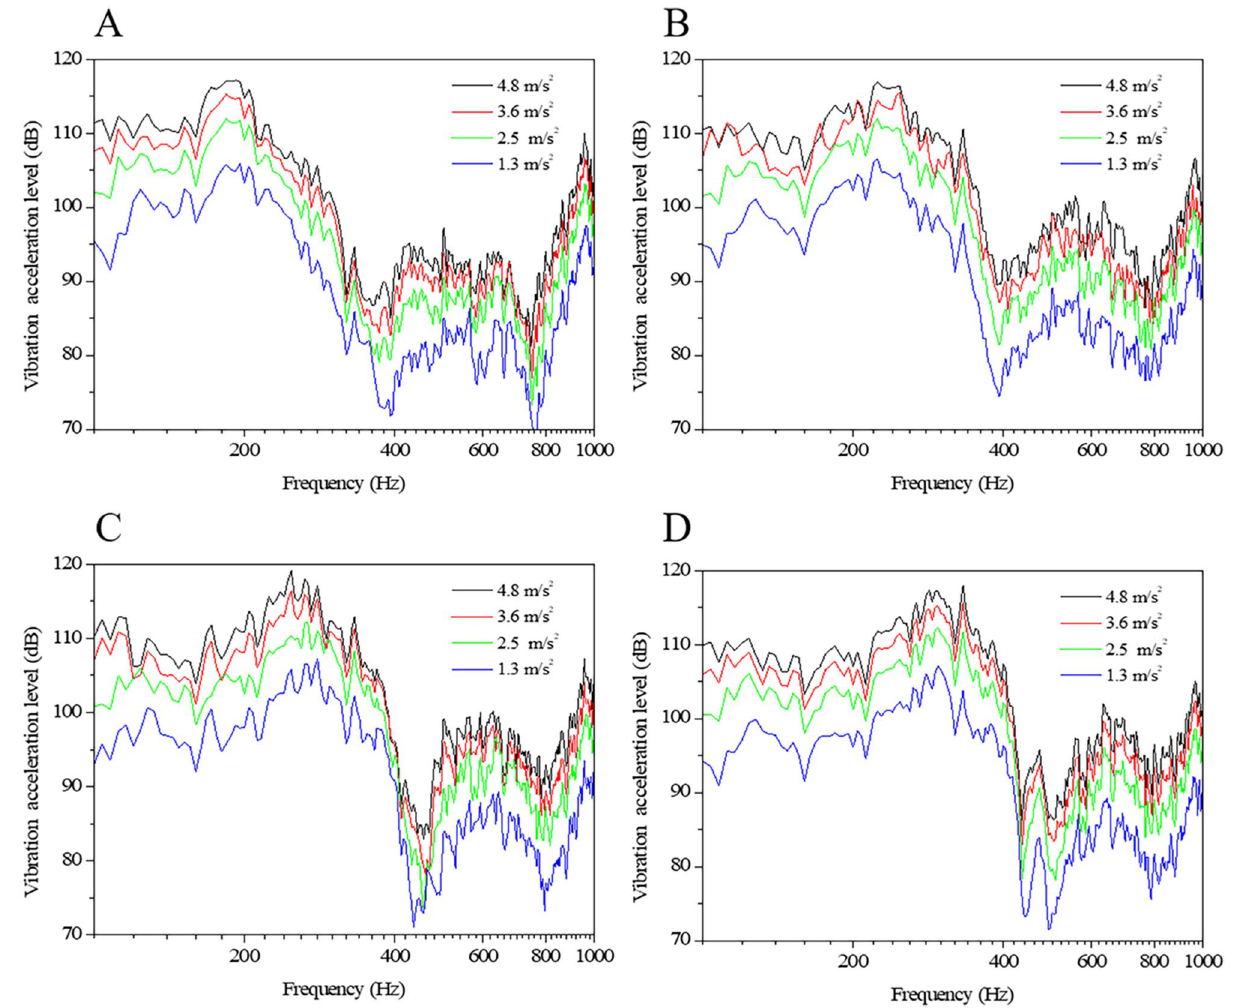
Figure 3. Auto-spectrum responses of eyeball 2 according to varying excitation and IOP levels ( A ) IOP 15 mmHg ( B ) IOP 30 mmHg ( C ) IOP 45 mmHg ( D ) IOP 60